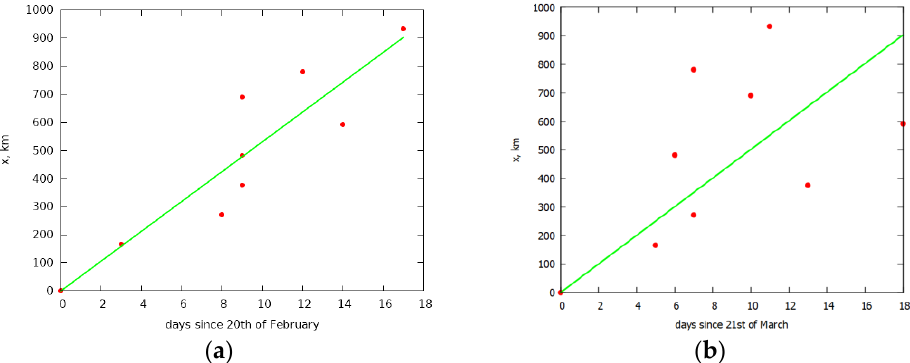
Figure 2. Graphs for determining ( a ) speed of spread of the epidemic and ( b ) speed of recovery in Italy. Points in ( a ) correspond to the day on which at least 5 cases in a band were detected. Points in ( b ) correspond to a maximum of infection cases per day in a band. The lines are built using least squares method.